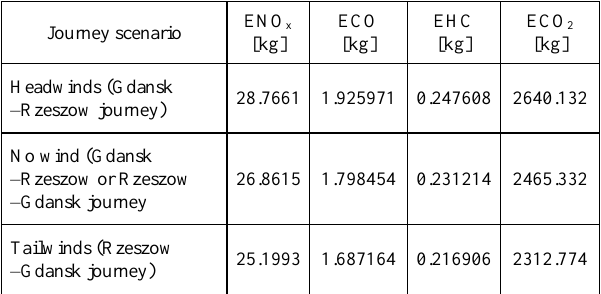
Table 5. Total emission of NO x , CO, HC and CO 2 in the exhausts of Gulfstream IV in each scenario of the journey Journey scenario